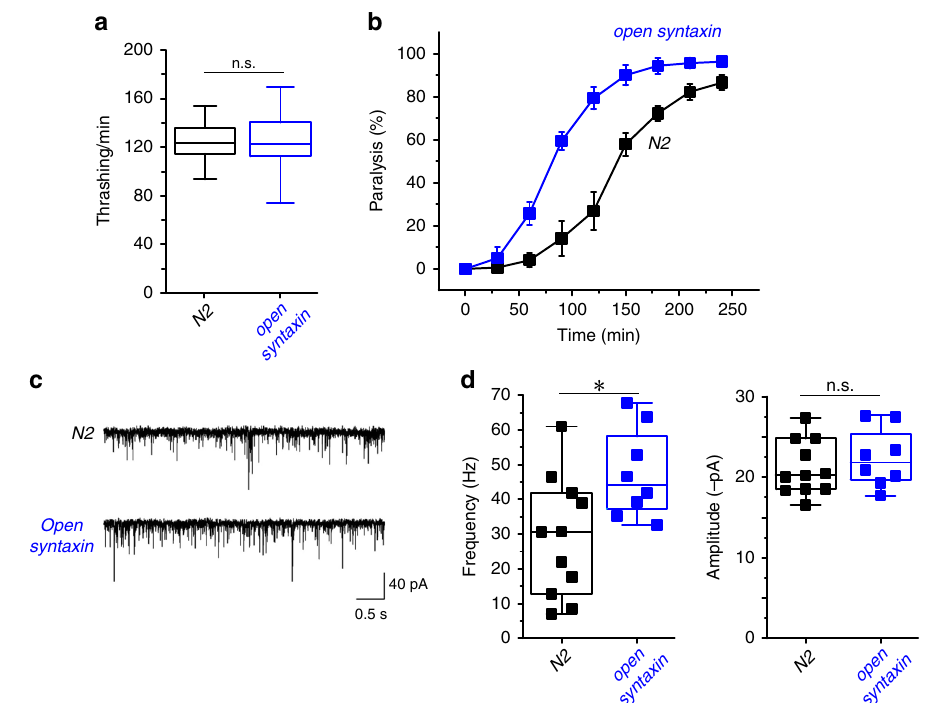
Fig. 1 The knock-in open syntaxin mutation enhances exocytosis on a wild-type background. a Box-and-whisker plots of motility for each strain, which was measured by counting the number of thrashes per min in M9 buffer. Knock-in open syntaxin C. elegans display similar thrashing rates as wild-type C. elegans (122 thrashes/min vs. 125 thrashes/min respectively). n = 51 for each strain. In two-sample two-sided t -tests, t (100) = 0.745, p = 0.46. n.s. = not signi fi cant. b Aldicarb assays were conducted to measure aldicarb resistance of the animals. The open syntaxin KI mutant exhibits greater sensitivity to aldicarb compared to N2 wild-type worms. n = 6. Each assay was conducted with 15 – 20 worms. Error bars represent SEM. c Representative traces of mPSCs recorded from N2 (top) and open syntaxin KI (bottom) worms. d Box-and-whisker plots overlaid with the corresponding data points (squares) of mPSCs frequency (left) and amplitude (right) of N2 and open syntaxin KI worms. Two-sample two-sided t -test, * p = 0.02; n.s. p = 0.44. n = 11 for N2 and n = 8 for open syntaxin animals. Box-and-whisker plots represent the median (central line), 25th – 75th percentile (bounds of the box), and 5th – 95th percentile